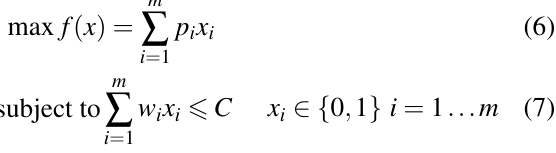
Algorithm portfolio based scheme for dynamic optimization problems